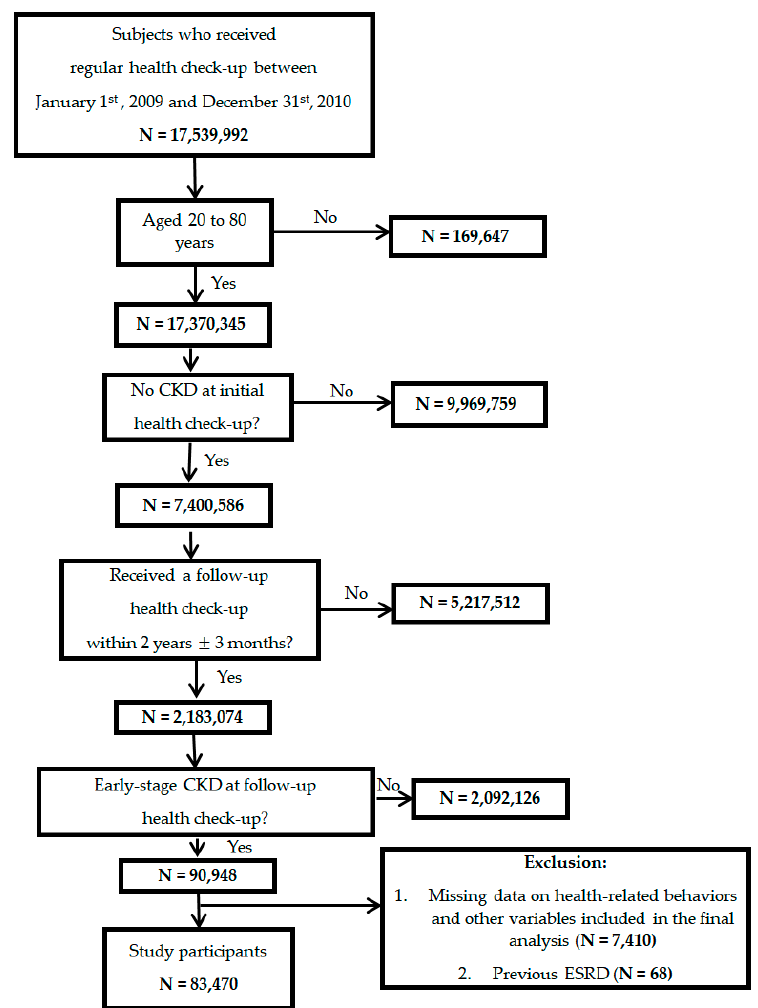
Figure 2. Patient flow. CKD, Chronic Kidney Disease; ESRD, End Stage Renal Disease.